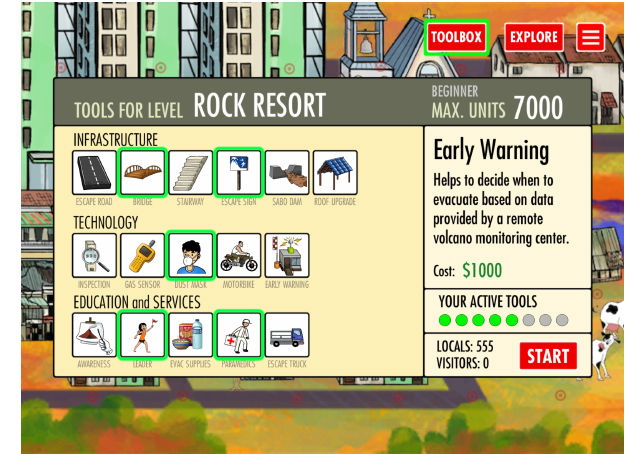
Figure 9. The toolbox includes 16 tools that can be used to address issues of mitigation and response to volcanic